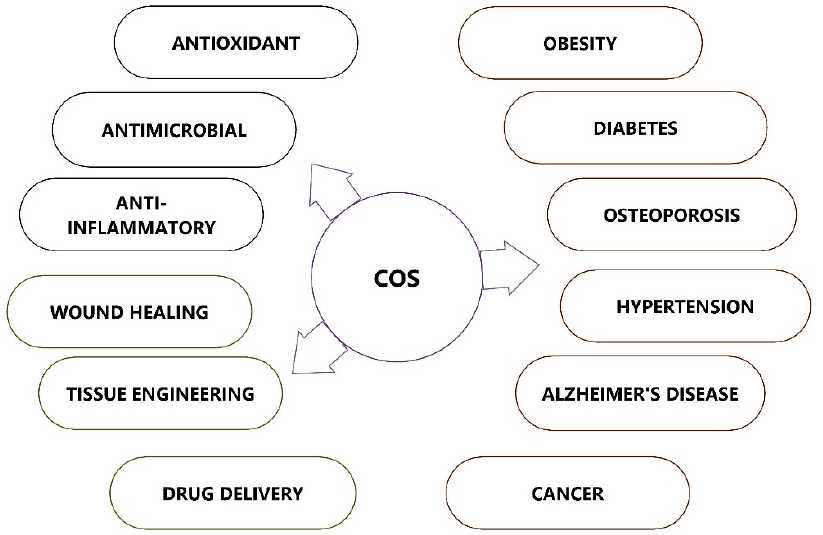
Figure 4. Therapeutic applications of chitooligosaccharides (COSs).